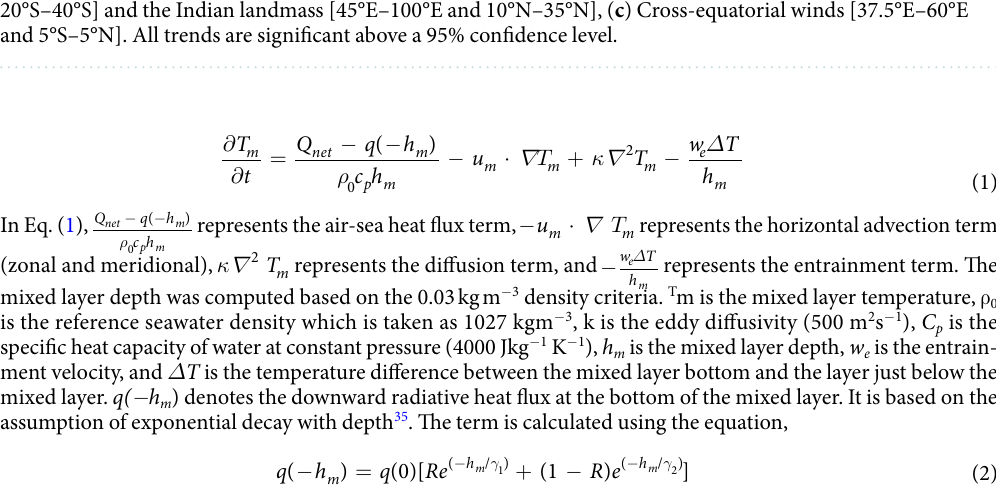
where u and v are the zonal and meridional currents, respectively.